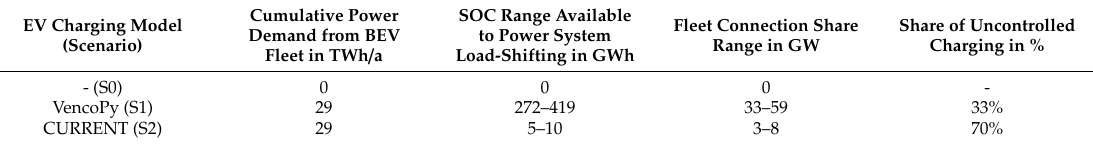
Table 6. Summary of fleet power demand flexibility characteristics in the three scenarios considered (S0, S1, and S2). Cumulative power demand includes losses during charging. SOC range gives the minimum and maximum di ff erence between SOC max and SOC min. Fleet connection share includes uncontrollably charging BEVs. For SOC and fleet connection ranges, VencoPy daily minimum and maximum hours, for CURRENT weekly minimum and maximum hours are used.